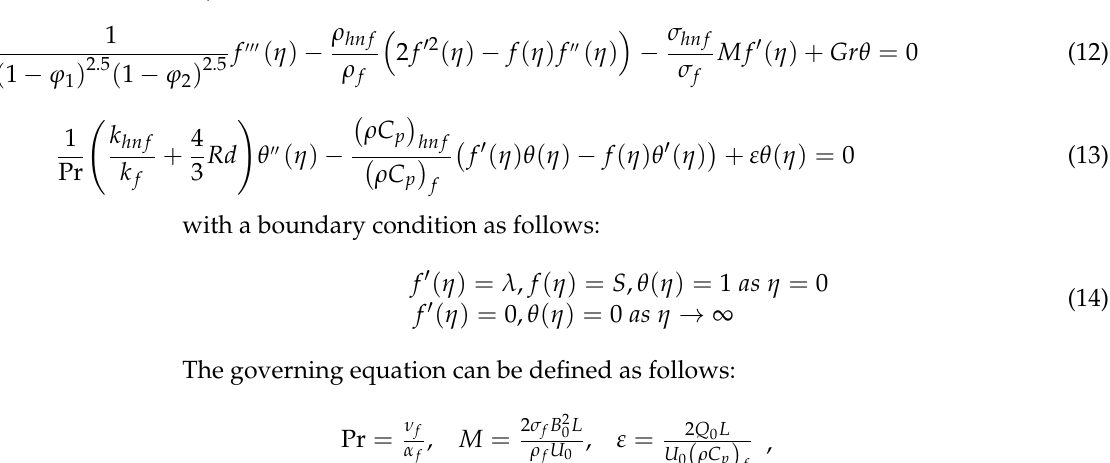
Equation (9) is substituted into Equations (1), (2), (7), and (8) using similarity